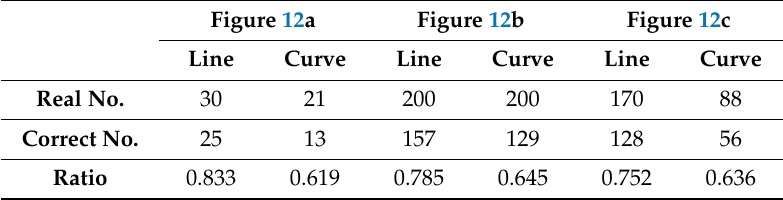
Table 1. Results in Figure 12 (unit: number).